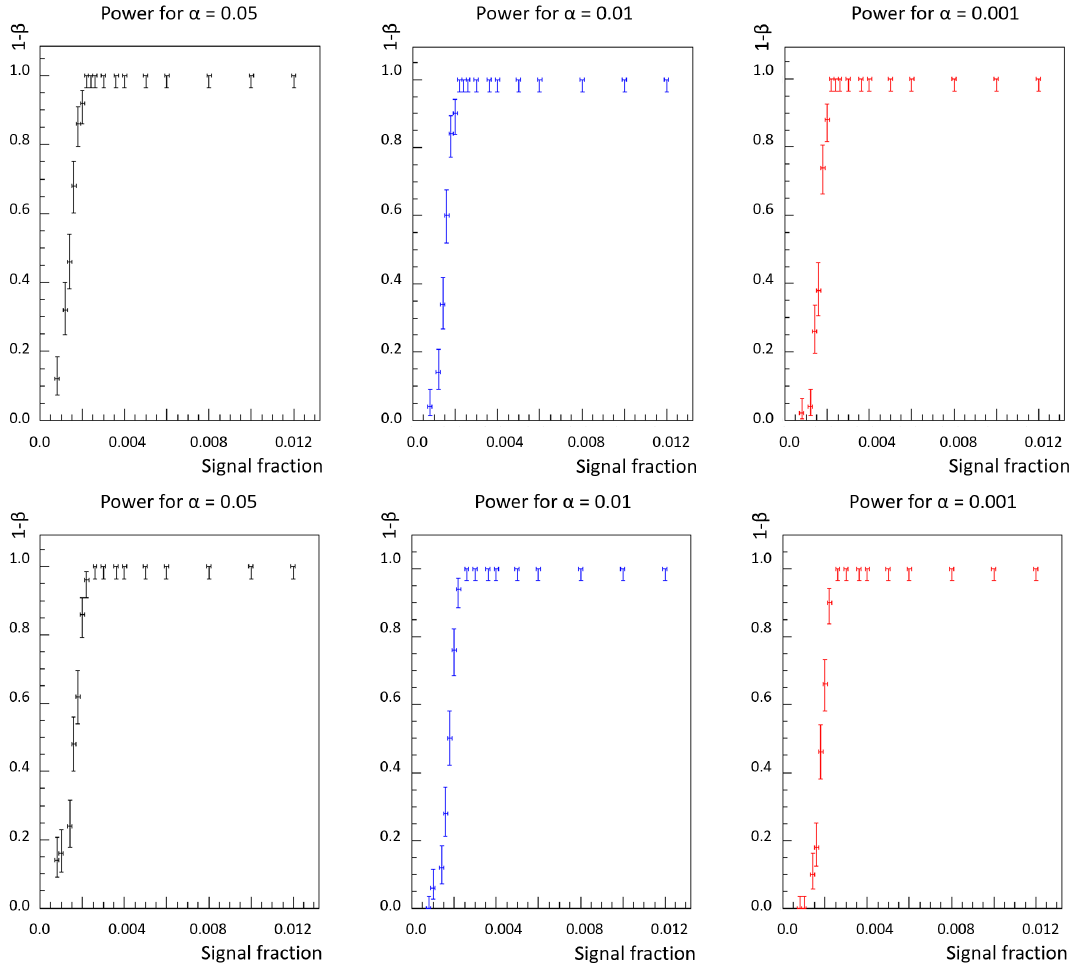
Figure 7 . RanBox (top) and RanBoxIter (bottom) power curves for Z PL as a function of the fraction of signal in 5000-event samples. The black points (left) correspond to α = 0 . 05 , the blue points (center) to α = 0 . 01 , and the red points (right) to α = 0 . 001 ; the critical region for the latter two tests are obtained from extrapolated values of Z for the null hypothesis. 68 . 3% intervals are PL computed with the Clopper-Pearson method for the Binomial ratio. See the text for more